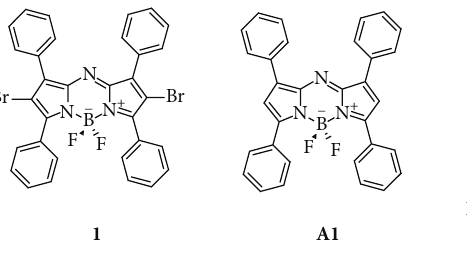
Figure 2: Structures of BODIPY 1-2 and A1-A2